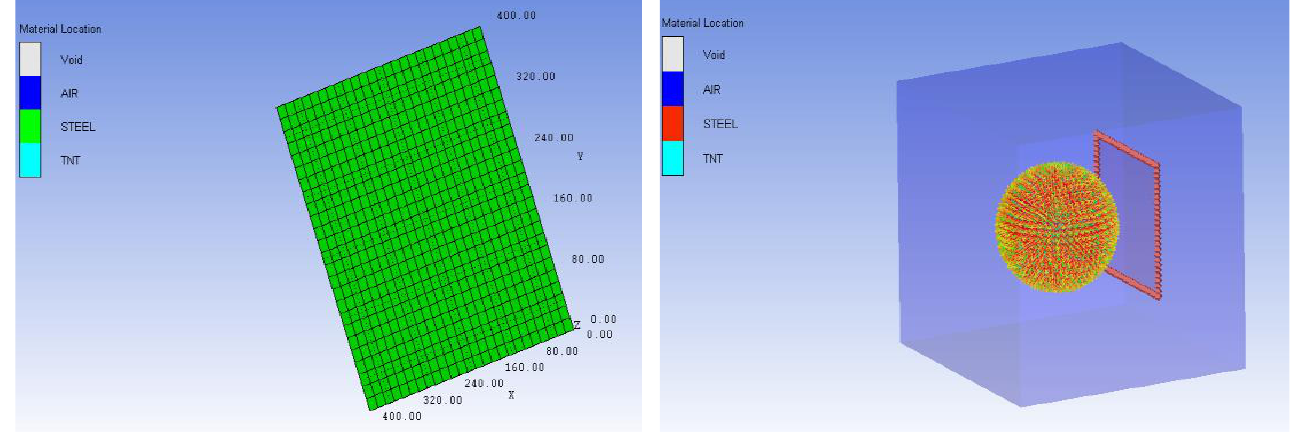
Figure 9. Blast test simulation.